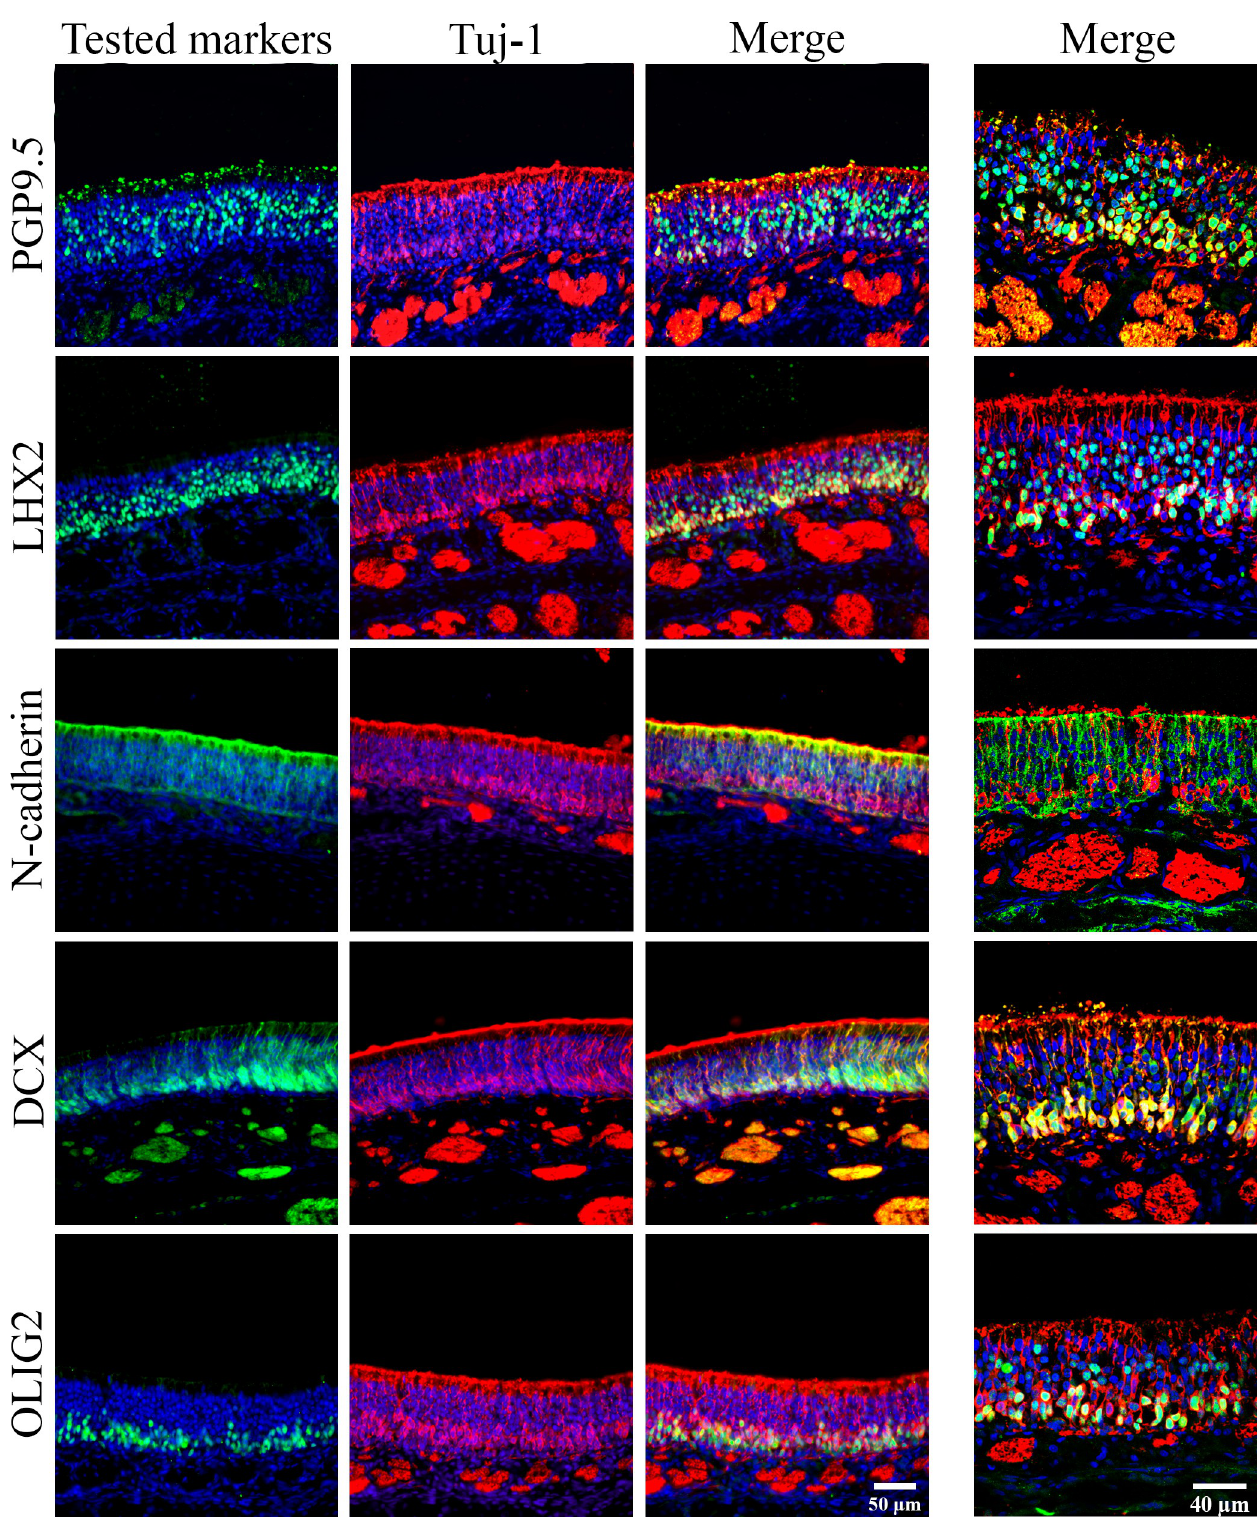
Fig 4. Co-localization of different OSN markers with Tuj-1, an immature OSN marker. IHC on cross sections of olfactory mucosa. The tested markers were colored in green and their name were noted on the left of each line of images. The nuclei were stained in blue using DAPI. The images of the 3 left columns were acquired using an epifluorescence microscope, with a 40X objective. The images of the right column were acquired from a confocal microscope with a 60X objective. https://doi.org/10.1371/journal.pone.0280497.g004 PLOS ONE | https://doi.org/10.1371/journal.pone.0280497 January 17,